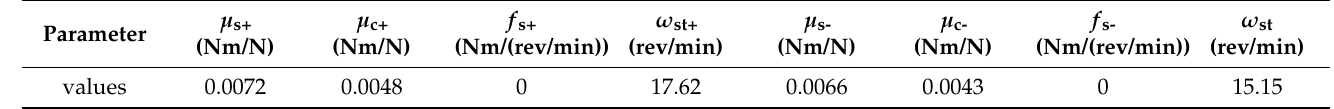
Figure 6. No-back friction identification with PSO algorithm. Table 2. Identification results of friction model